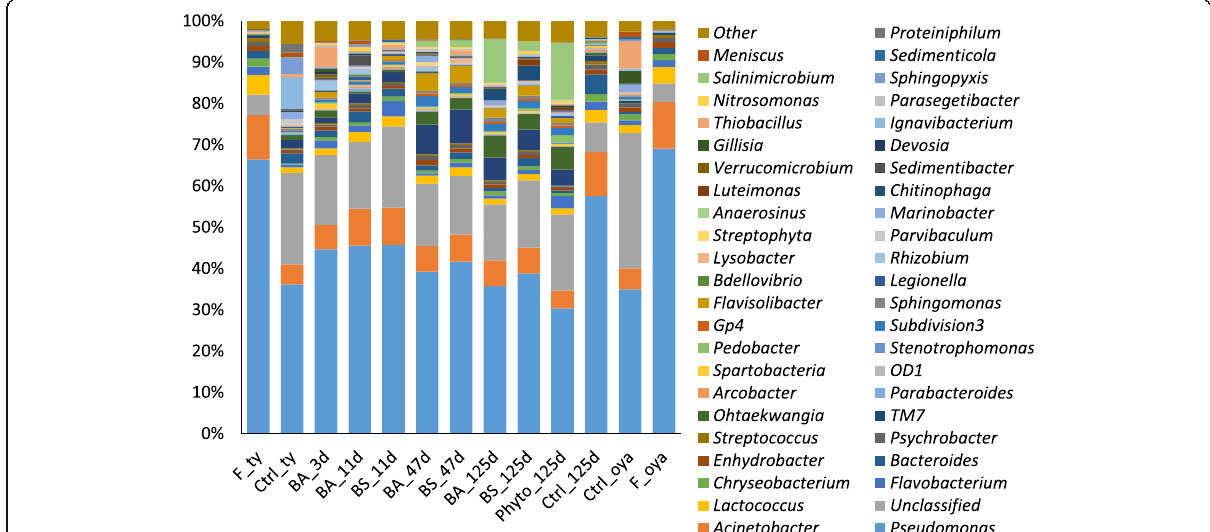
Fig. 5 Distributions of bacteria in the 13 samples at the genus level. Taxa were represented at > 0.5% frequency in at least one sample. “ Others ” refers to the taxa with a maximum abundance of < 0.5% in any sample. Unclassified refers to the sequences that could not be assigned to known bacterial genus. F_ty stands for the sample collected from a farmland neighbouring the contaminated field this year. BA_3d, BA_11d, BA_47d, and BA_125d represent the samples collected after 3, 11, 47, and 125 days, respectively, from the beginning of the remediation process in the BA block. BS_11d, BS_47d, and BS_125d represent the samples collected after 11, 47, and 125 days, respectively, from the beginning of the remediation process in the BS block. Phyto_125d represents the sample collected 125 days after the beginning of the remediation process in the